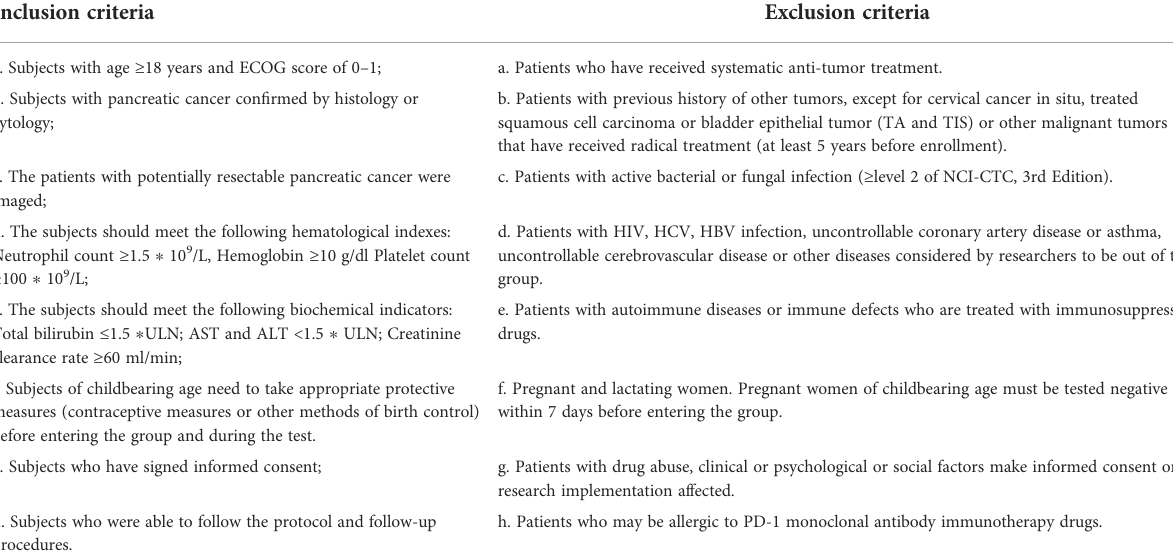
TABLE 2 The inclusion and exclusion criteria of the protocol.